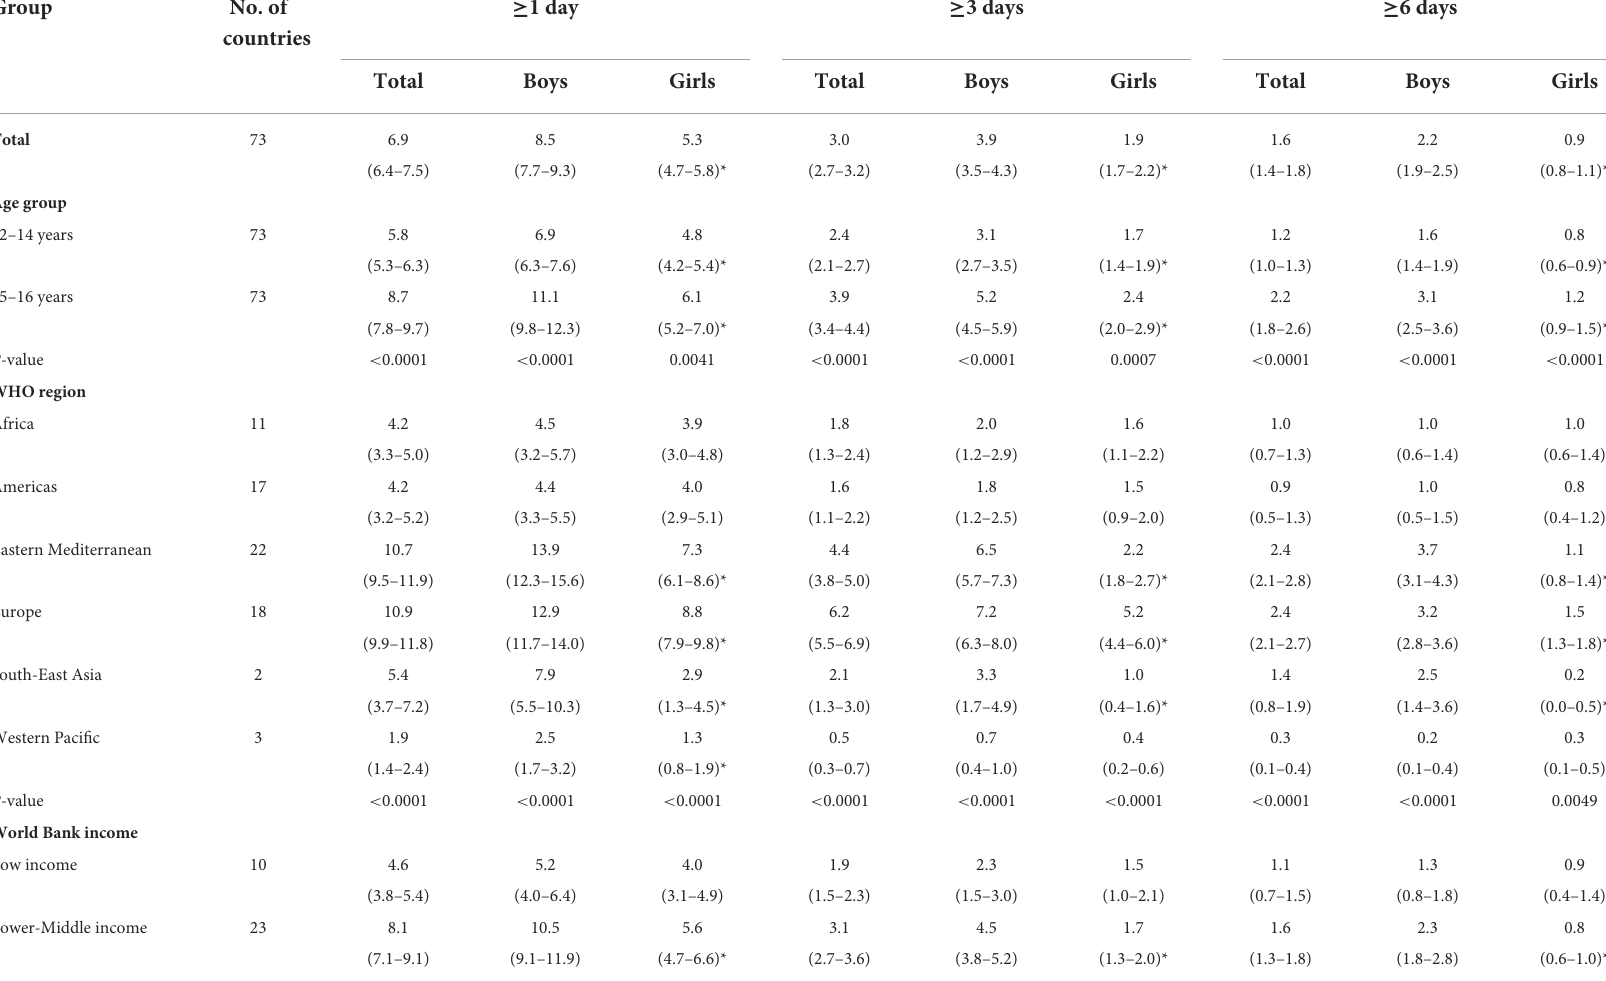
TABLE 1 Prevalence of waterpipe smoking among adolescents aged 12–16 years by use frequency, sex, age group, WHO region, World Bank income category, cigarette use, secondhand smoke exposure, and parental smoking, 2010–2019.